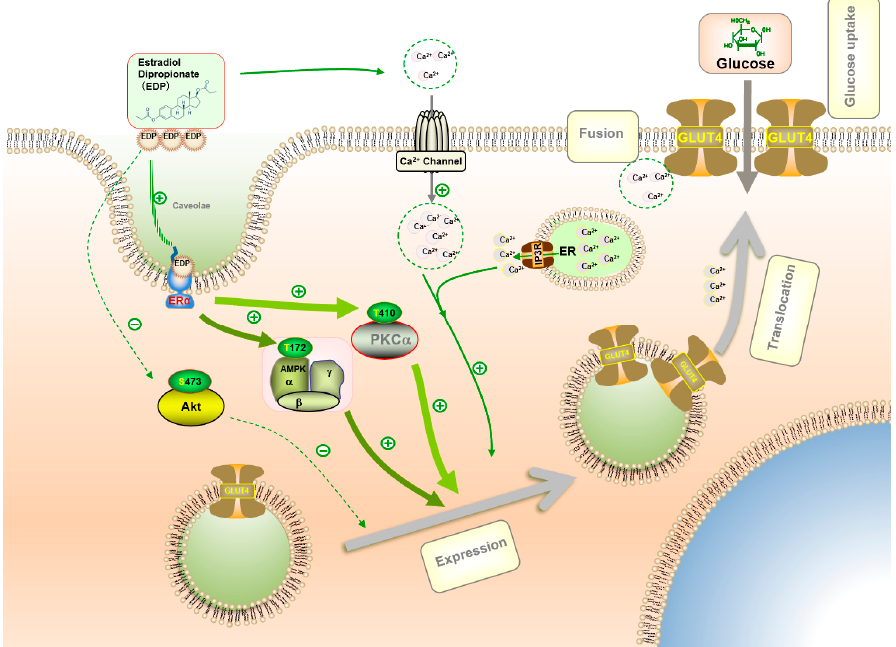
Figure 8. Estradiol Dipropionate (EDP) promotes the main pathways of uptake of glucose in L6 cells. EDP promotes GLUT4 expression through PKC and AMPK pathways, which in turn enhances GLUT4 fusion with the plasma membrane, while EDP also increases intracellular Ca 2+ concentration in L6 cells, thereby performing uptake of glucose. Thus, both EDP-induced GLUT4 fusion into the plasma membrane and uptake of glucose were Ca 2 + dependent.